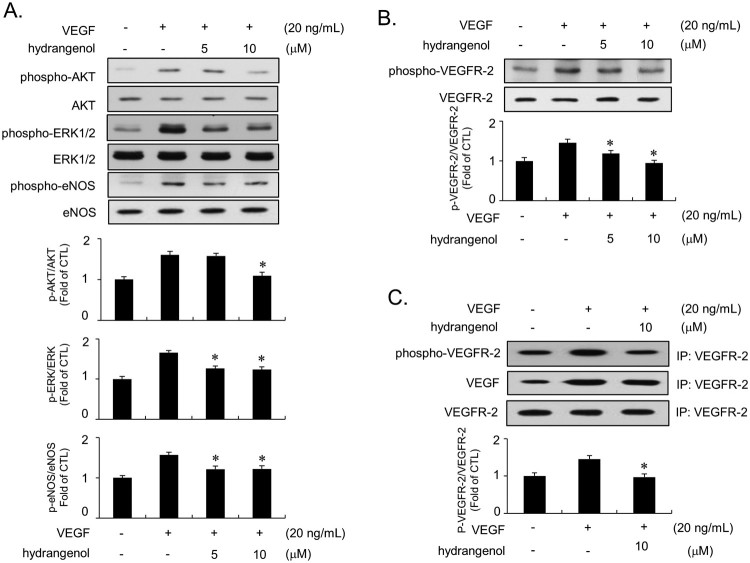
Inhibitory activity of hydrangenol against the phosphorylation of ERK1/2, AKT, eNOS, and VEGFR-2 in VEGF-stimulated HUVECs. HUVECs were pre-incubated with indicated concentrations of hydrangenol, followed by incubation in the presence of VEGF. (A) Immunoblots were performed using antibodies specific for phospho-ERK1/2, ERK1/2, phospho-AKT, AKT, phospho-eNOS, and eNOS. (B) Effect of hydrangenol on VEGFR-2 was assessed by the immunoblot assay, which employed anti-phospho VEGFR-2 antibody. (C) Immunoprecipitation was performed using the anti-VEGFR-2 antibody, and the immunoblot assay was subsequently performed using the phospho-VEGFR, VEGF, and total VEGFR-2 (input) antibodies. Values in bar graphs were presented as a fold change compared with the control group (untreated). Statistical analysis was performed using unpaired Student's t-test for VEGF alone vs. VEGF + hydrangenol-treated groups. Values were presented as ±SEM from three independently repeated experiments. Values at *p < 0.05 were considered significant.